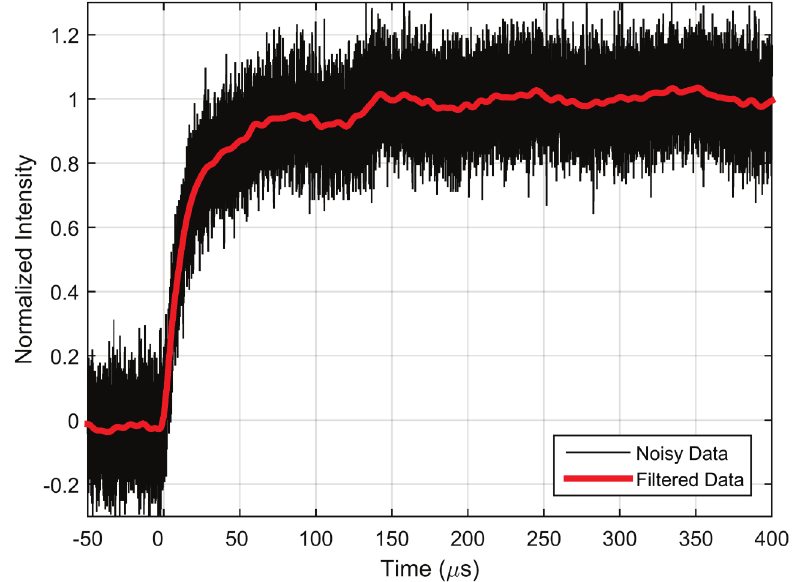
Figure 4. Normalized PMT signal and the corresponding filtered